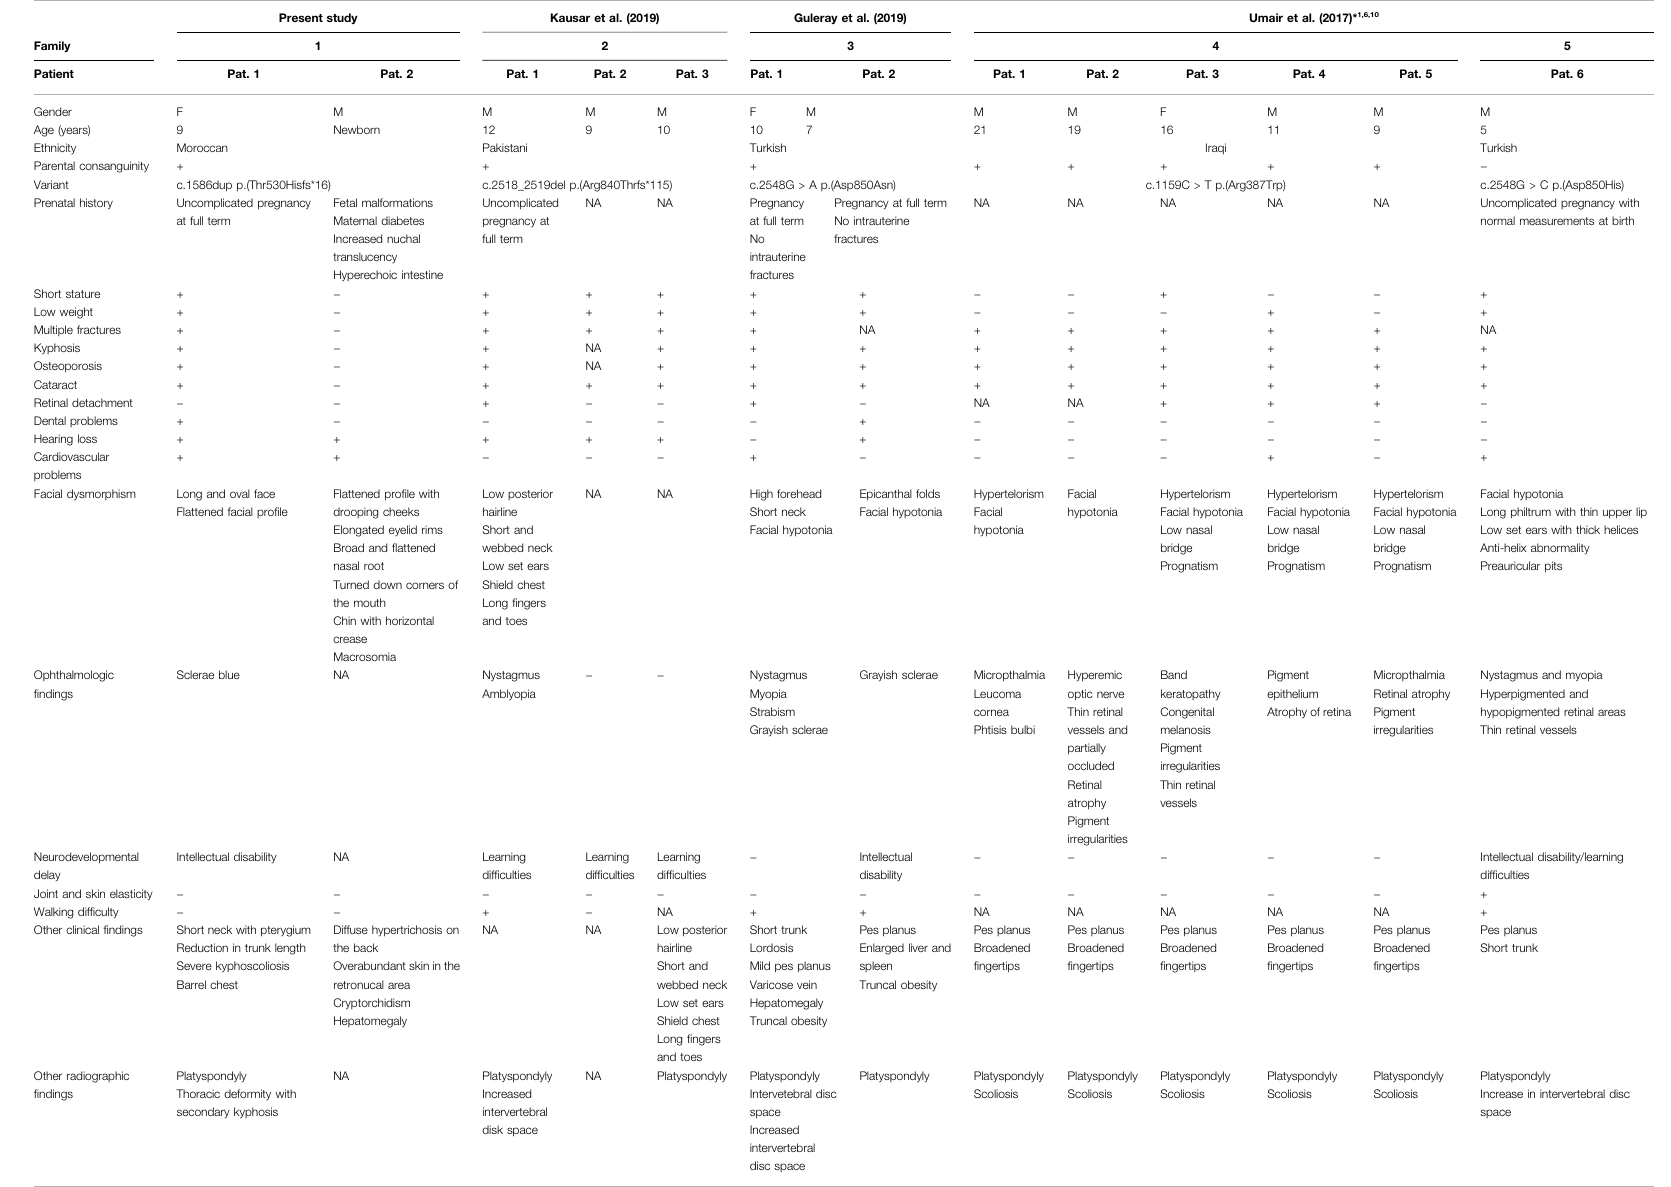
TABLE 1 | Clinical features of the present case compared with the previously reported patients with XYLT2